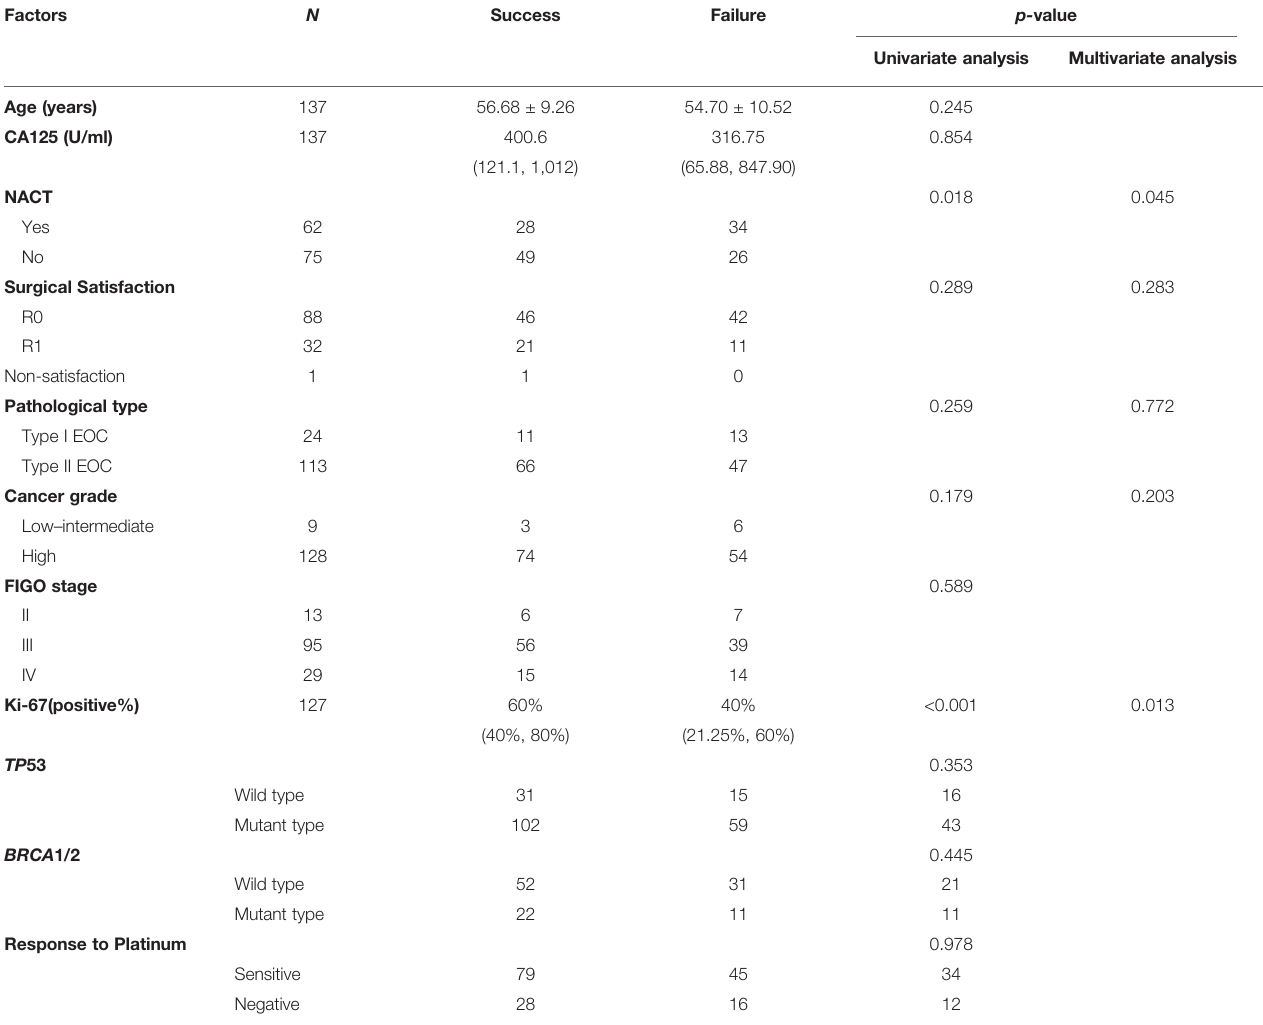
TABLE 1 | Factors affecting engraftment rates in primary EOC-PDX models. Factors